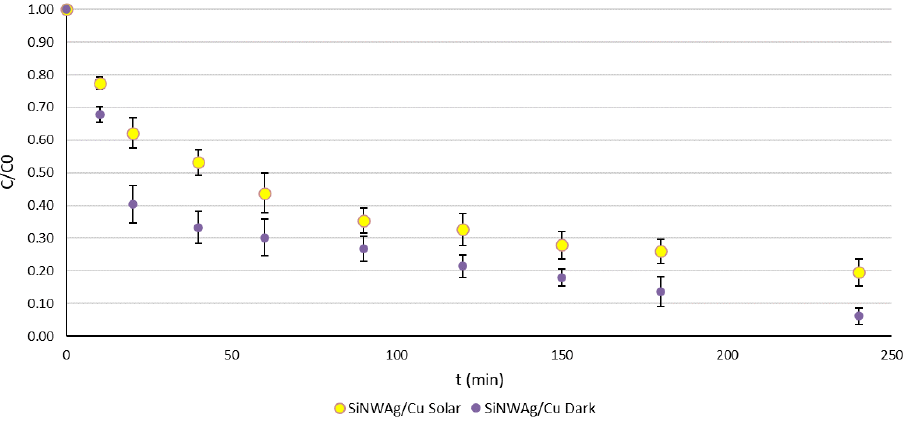
Figure 7. Triplicates of C 0 = 15 mg/L Cr(VI) reduction, in the presence of 5 mM citric acid and 1.2 g catalyst/L, under simulated solar irradiation and dark conditions, at pH 2.8. 1.2 g catalyst/L, under simulated solar irradiation and dark conditions, at pH